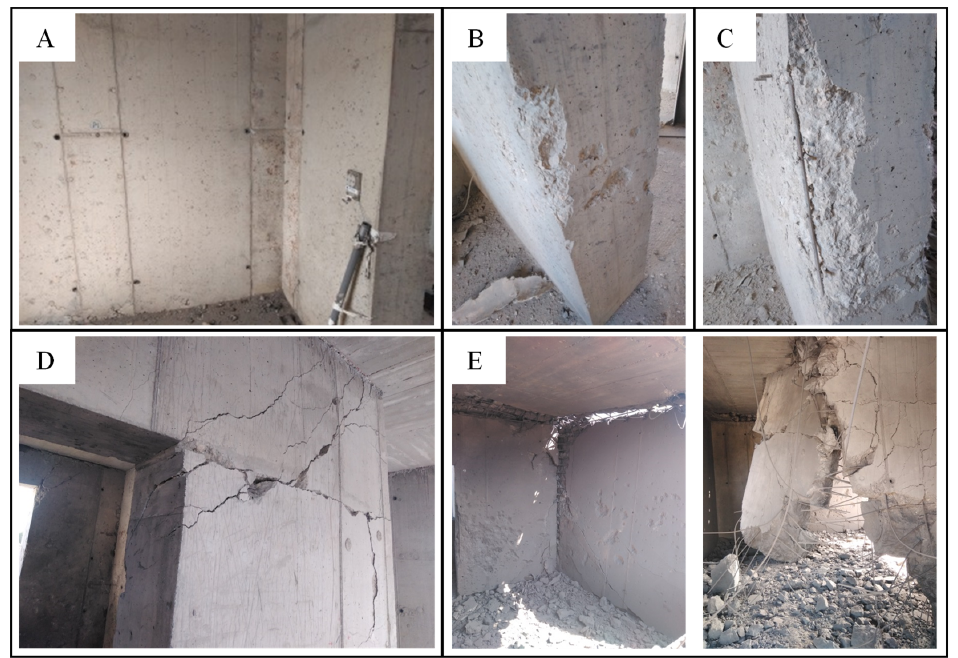
Figure 13. Different effects of IEDs on the interior structure: ( A ) after the two black powder tests (T1–T2); ( B ) after the ANFO tests (T3–T4); ( C ) after the AN/AL tests (T5–T6); ( D ) after the first PG2 test (T7); ( E ) after the second PG2 test (T8).